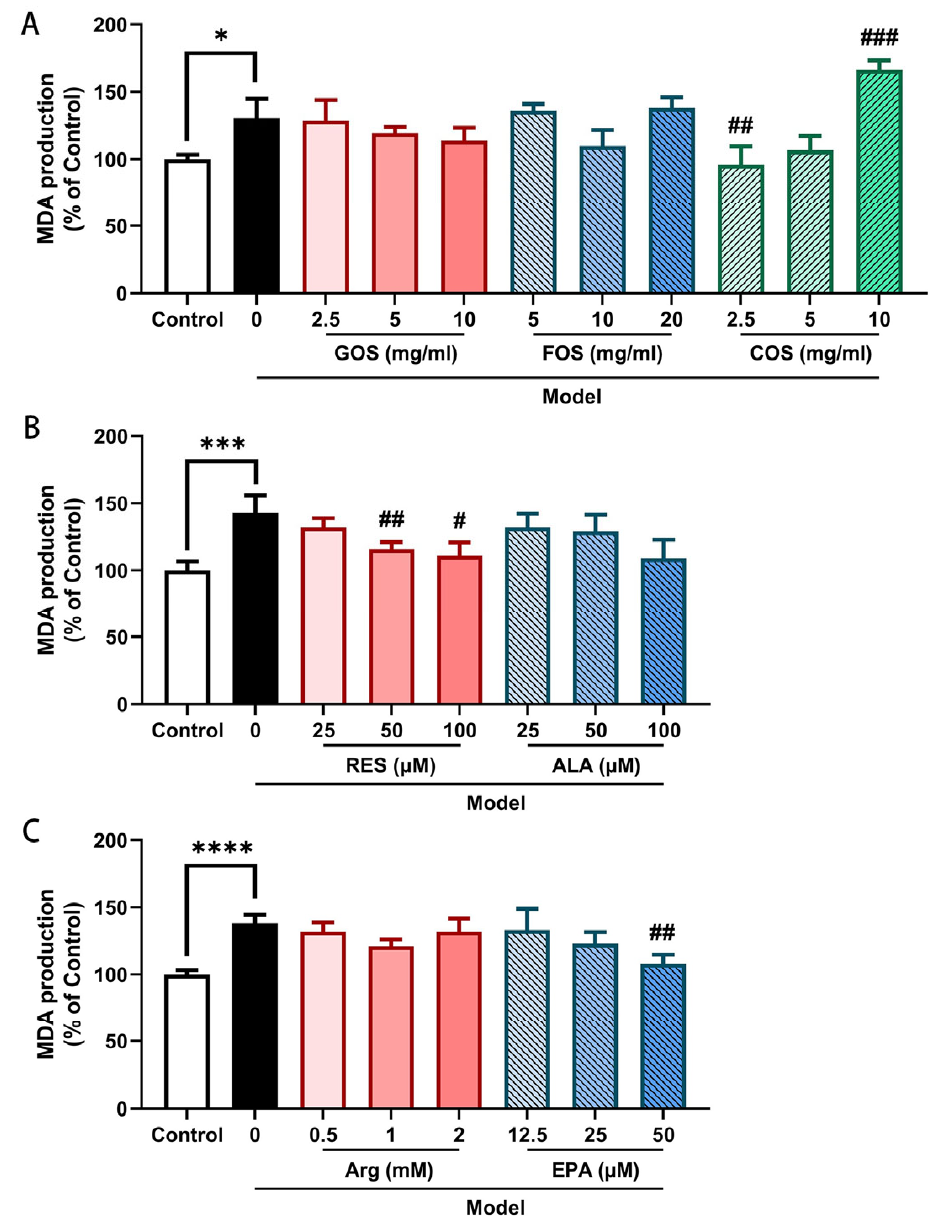
Figure 6. MDA production of Caco-2/HT-29 cell monolayers pre-incubated with GOS, FOS, COS ( A ), RES, ALA ( B ), Arg, and EPA ( C ) for 48 h then exposed to hypoxia and heat treatment (2 h). After hypoxia and heat treatment, MDA in the supernatant was determined by a thiobarbituric acid assay. All values were presented as means ± SEM (N = 3, n = 2 (GOS, FOS, COS group), and n = 3 (all other groups)). Statistical differences were analyzed by two-way ANOVA followed by the Bonferroni’s multiple comparison test. * p < 0.05, *** p < 0.001, and **** p < 0.0001 versus control; # p < 0.05, ## p < 0.01, and ### p < 0.001 versus model. MDA, malondialdehyde; GOS, galacto-oligosaccharides; FOS, fructo-oligosaccharides; COS, chitosan oligosaccharides; ALA, α -lipoic acid; RES, resveratrol; Arg, l-arginine; EPA, eicosapentaenoic acid. The detailed raw OD data are listed in Table